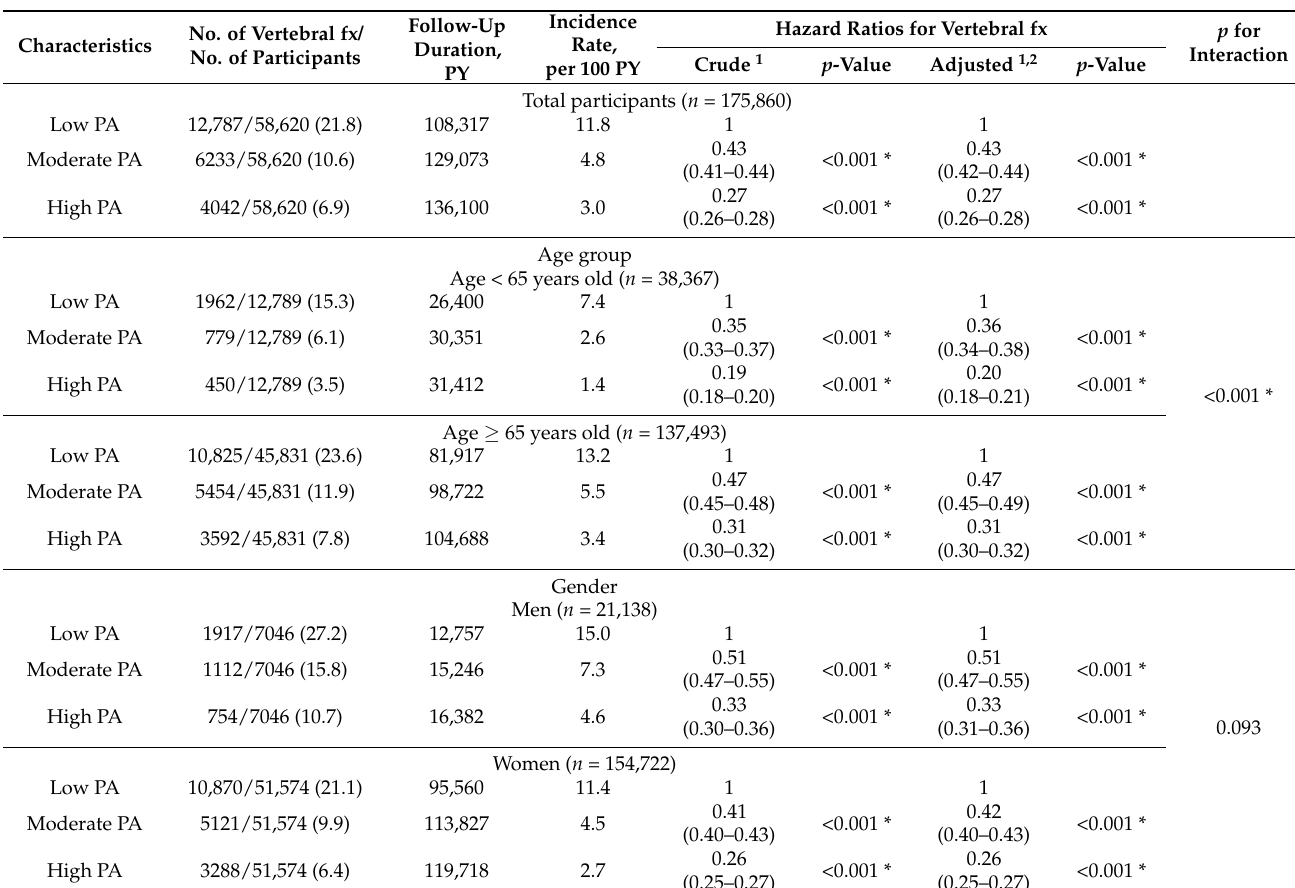
Table 2. HR (95% CIs) for vertebral fx in the PA groups with subgroup analyses according to age and